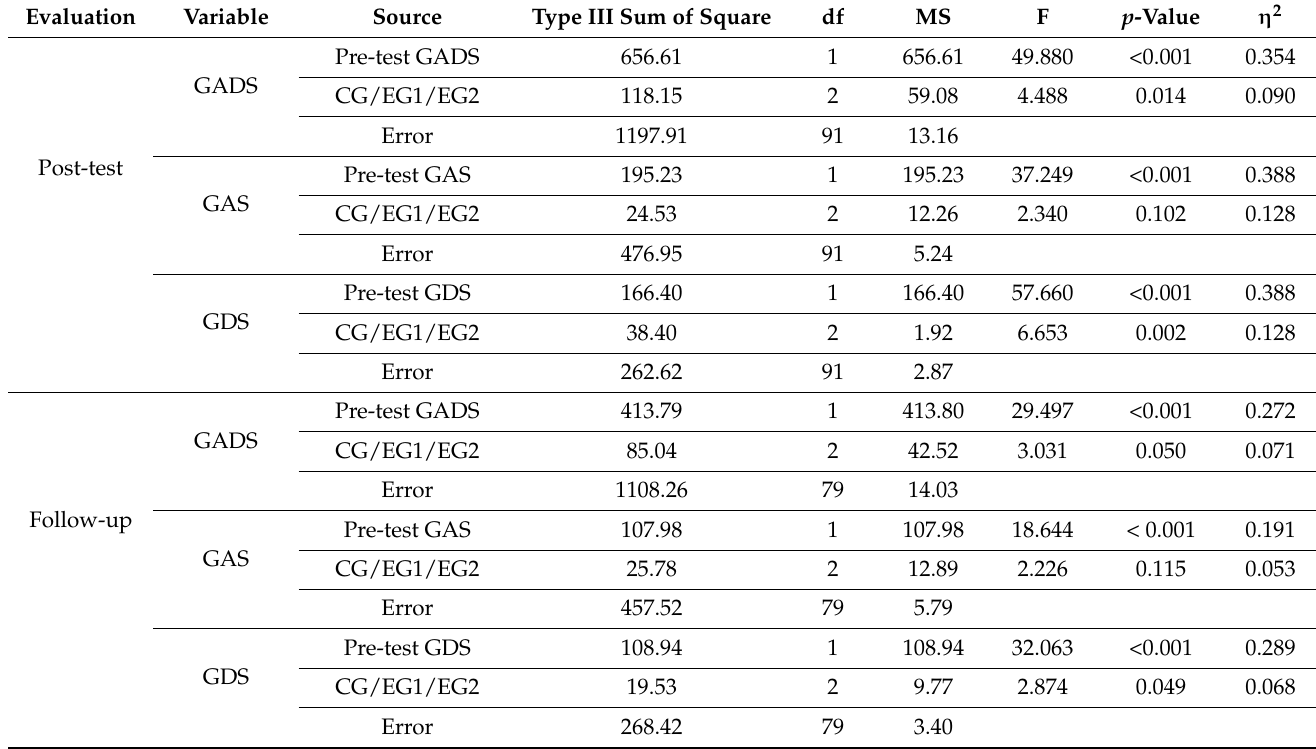
Table 4. Comparison between groups: post-test–follow-up punctuations with pre-test scores control. ANCOVA. Evaluation Variable Source